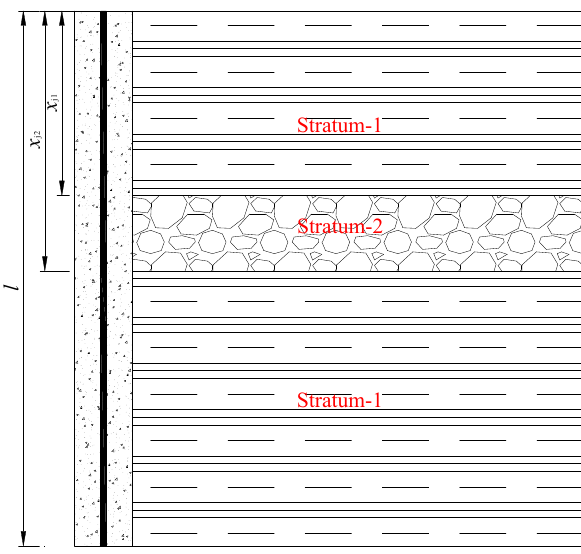
Figure 5. Ground anchors buried in sandwich